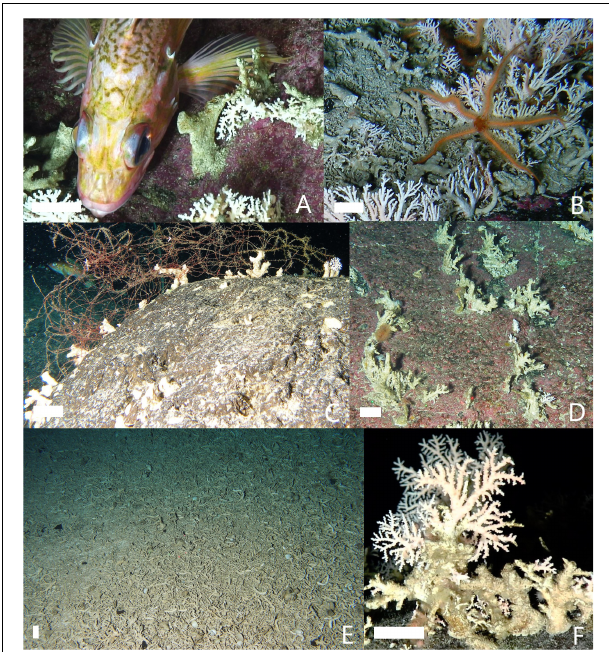
FIGURE 4 | Examples of associations and conditions of hydrocorals ( Stylaster spp.). Common associates with hydrocorals were (A) small rockfish species (e.g., rosethorn rockfish, Sebastes helvomaculatus ) tucked against colonies and (B) ophiuroids (class Ophiuroidea) perched on colonies. Colonies of hydrocorals (C) entangled in derelict fishing gear (DFG) and (D) on flat surfaces were most often reduced to dead branchless stumps. (E) Detached corals covered the sediment in continuous mats of rubble. (F) There were signs of new growth, some large stumps supported small live branches. White scale bars = 2